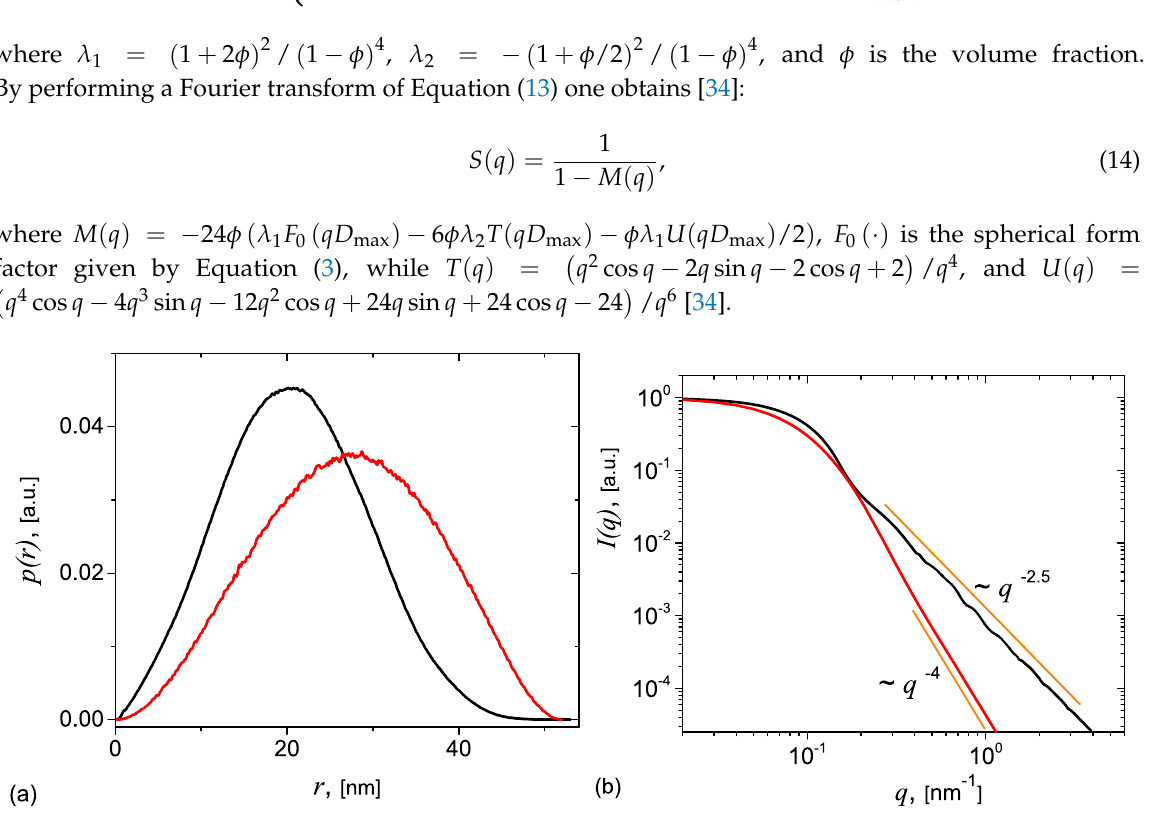
Figure 4. (Color online) ( a ) Pair distribution function p ( r ) of a 3D diffusion limited aggregation (DLA) cluster (black) and of a sphere of the same size (red). The number of distances used to calculate p ( r ) for each structure is (cid:39) 2.32 × 10 6 . ( b ) The corresponding form factors: DLA cluster (black), sphere